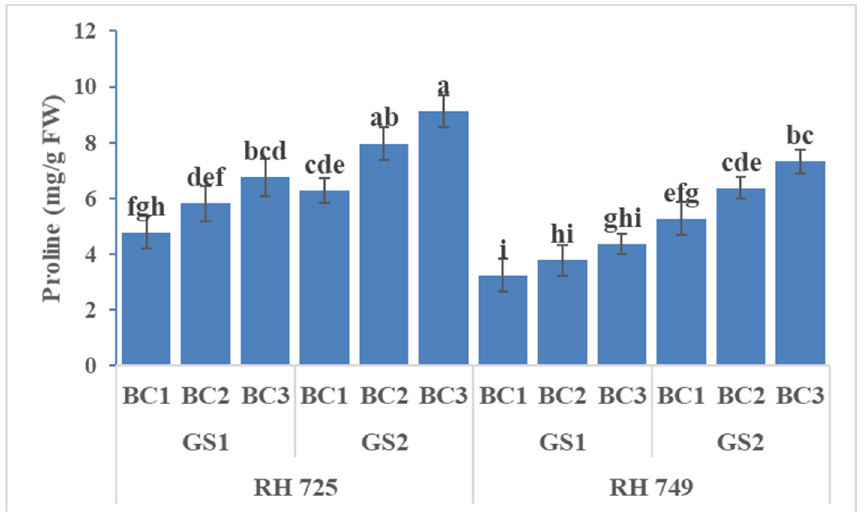
Figure 12. Comparisons of the effects of different concentrations of brassinolide sprays (BC1: control (water spray); BC2: 10 mg BRs/L water; BC3: 20 mg BRs/L water) on the proline content (PRO) of drought-tolerant (RH 725) and drought-sensitive (RH 749) Indian mustard cultivars at the flower initiation (GS1) and 50% flowering (GS2) stages. Columns marked by different letters indicate significant differences ( p < 0.05) between treatments based on Duncan’s multiple range test. Error bars denote the standard errors of the mean.